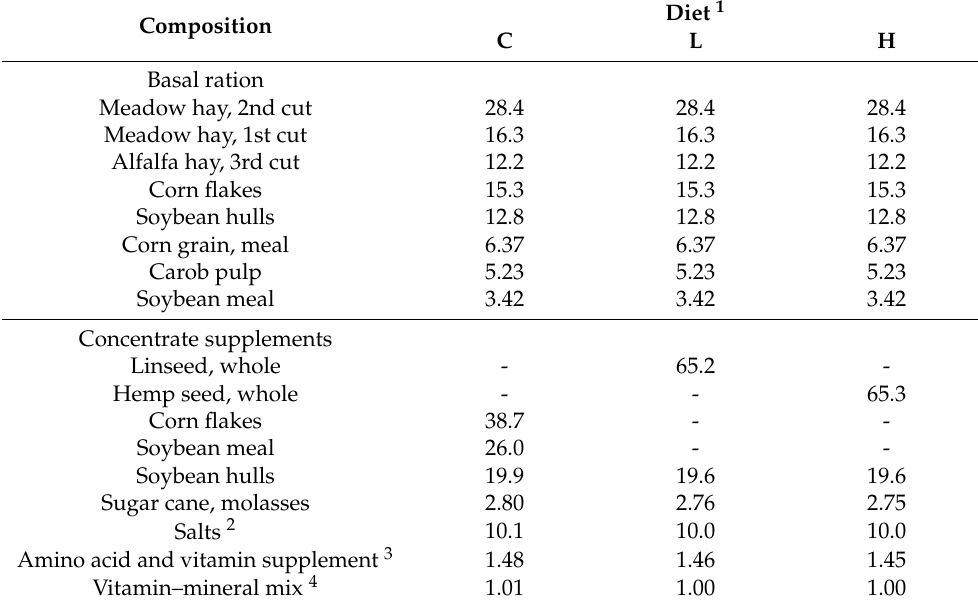
Table 1. Composition of the basal ration (85.6% of total diet DM) and of the three different